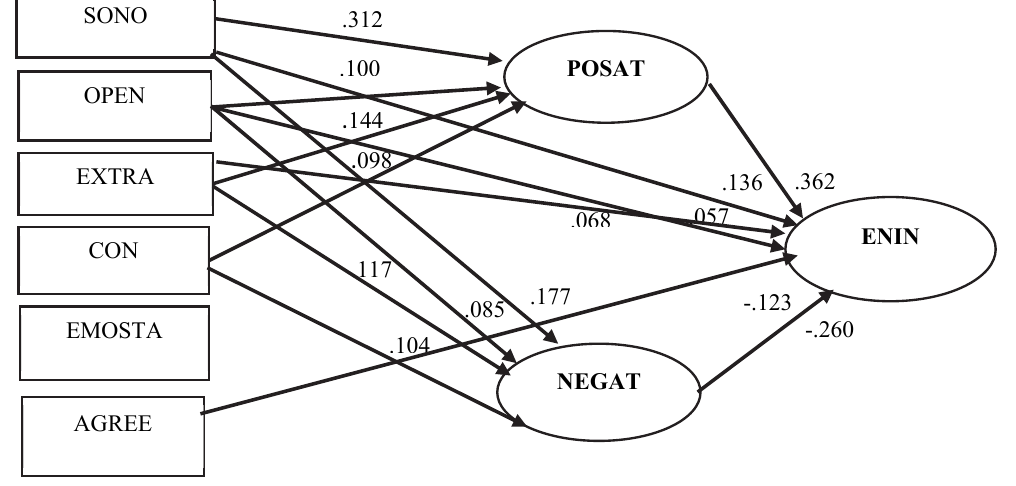
Fig. 1. Path coefficients of hypothesis